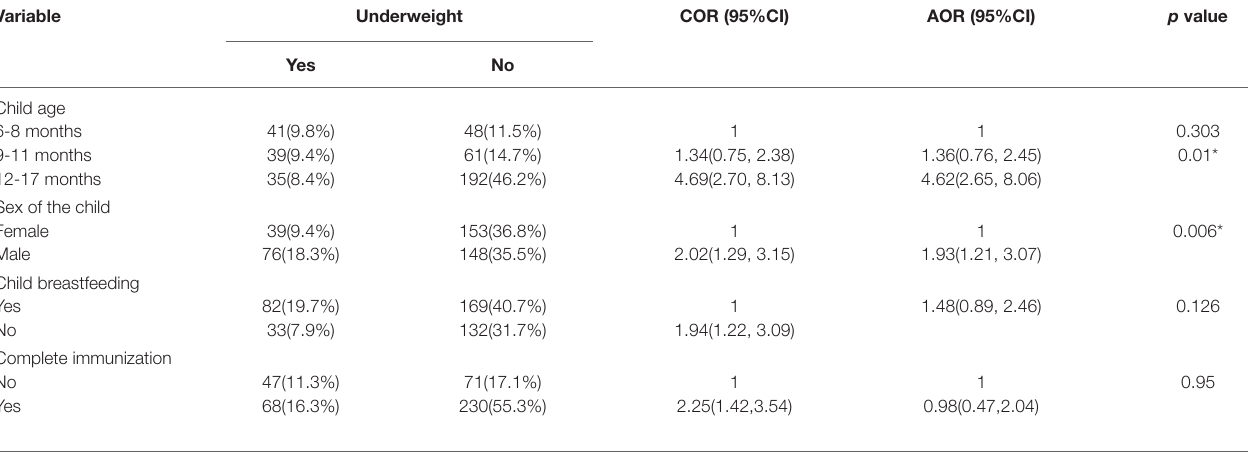
TABLE 8 | Factors associated with underweight in Dessie town, Northeastern Ethiopia, 2021.